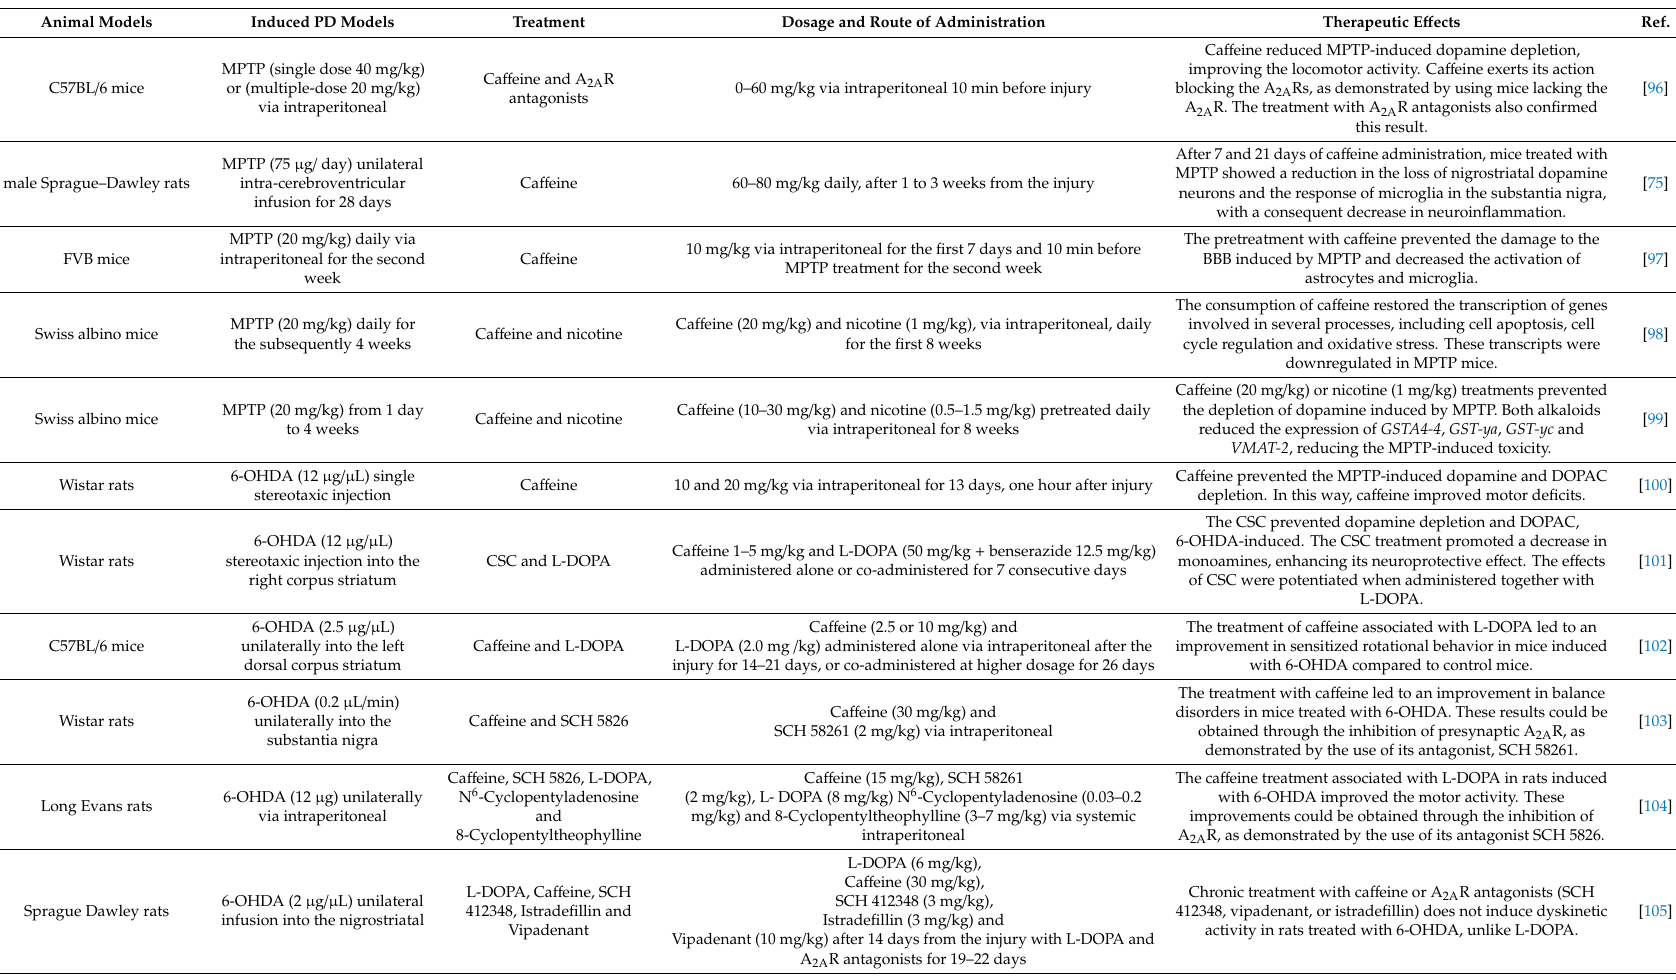
Table 1. Summary of the preclinical studies that evaluate the neuroprotective e ff ects of ca ff eine in the treatment of PD. Specifically, the table lists the animal models used in the studies, the type of treatment, the dosage and the therapeutic e ff ects